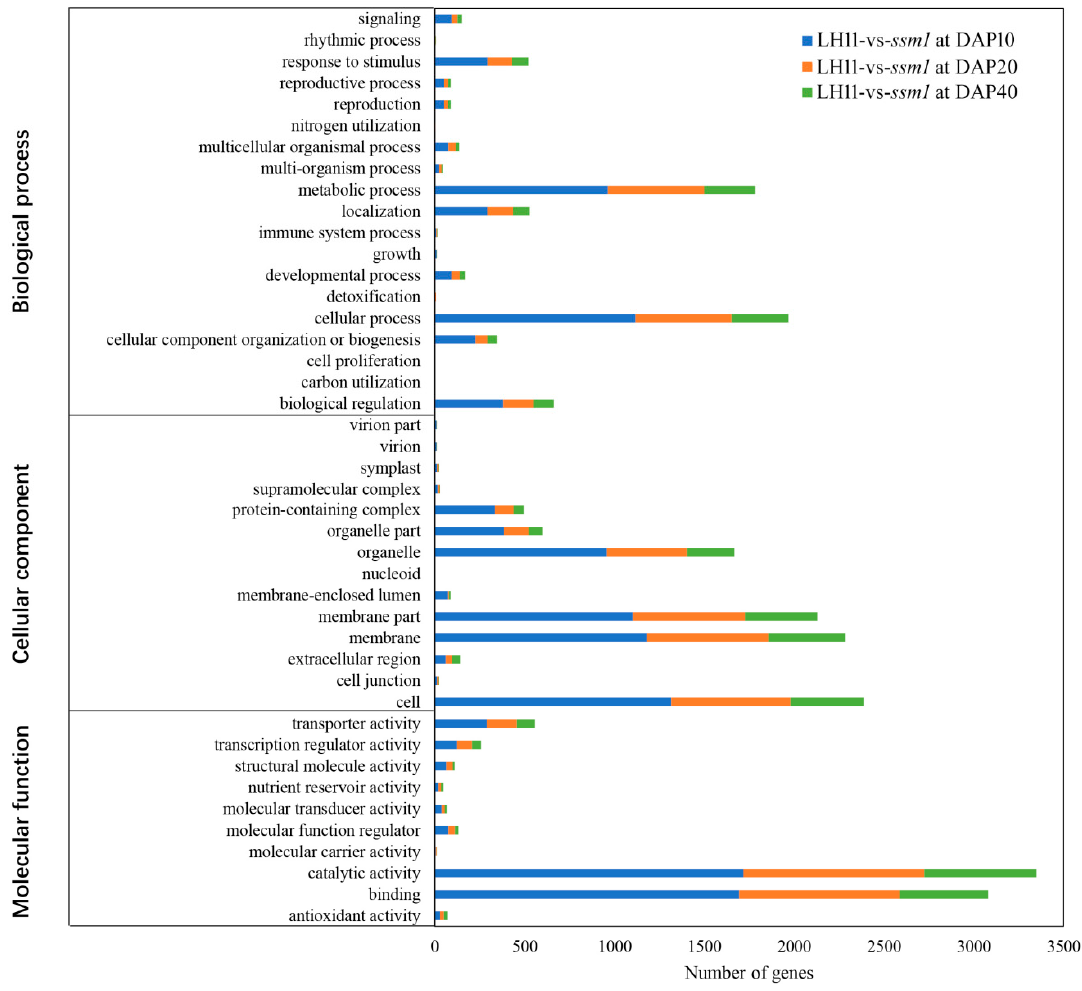
6 of 20 Figure 4. Comparison of DGEs between ssm1 and LH11 seeds. ( a ) Numbers of DGEs in seeds be- tween ssm1 and LH11 at DAP10, DAP20, and DAP40 three stages; ( b ) Scatter diagram of DEGs in seeds at DAP10 between ssm1 and LH11; ( c ) Scatter diagram of DEGs in seeds at DAP20 between ssm1 and LH11; ( d ) Scatter diagram of DEGs in seeds at DAP40 between ssm1 and LH11. Both the X and Y axes represent log10 values of gene expression. To gain insights into the functional categories of the DEGs between ssm1 and LH11, Gene Ontology (GO) enrichment analysis were conducted. The DEGs were classified into